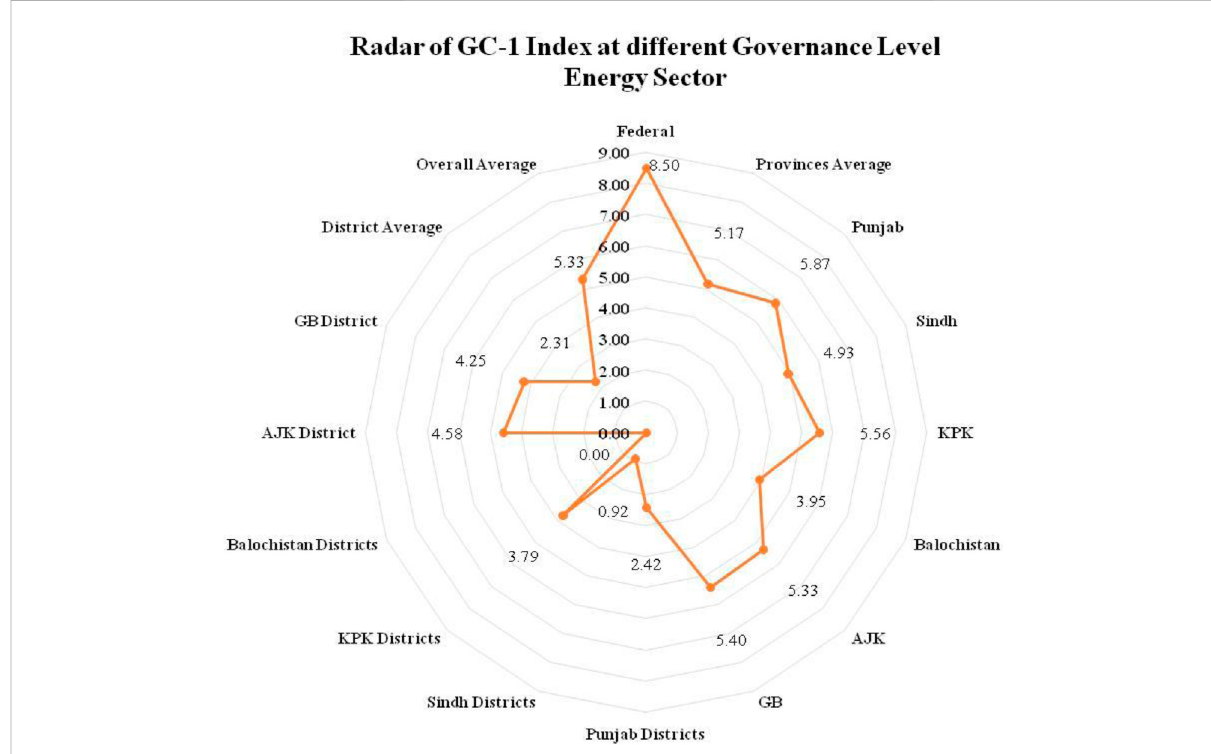
FIGURE 3 Radar graph of governance index for Governance Component-1 in the energy sector.